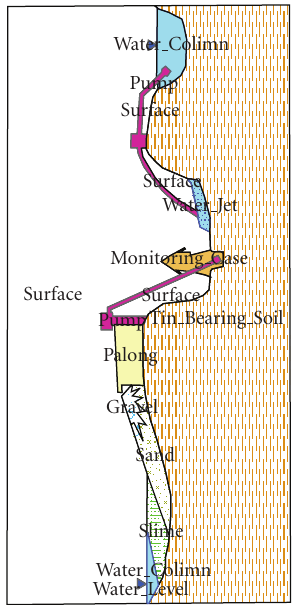
Figure 4: Gravel pump mining